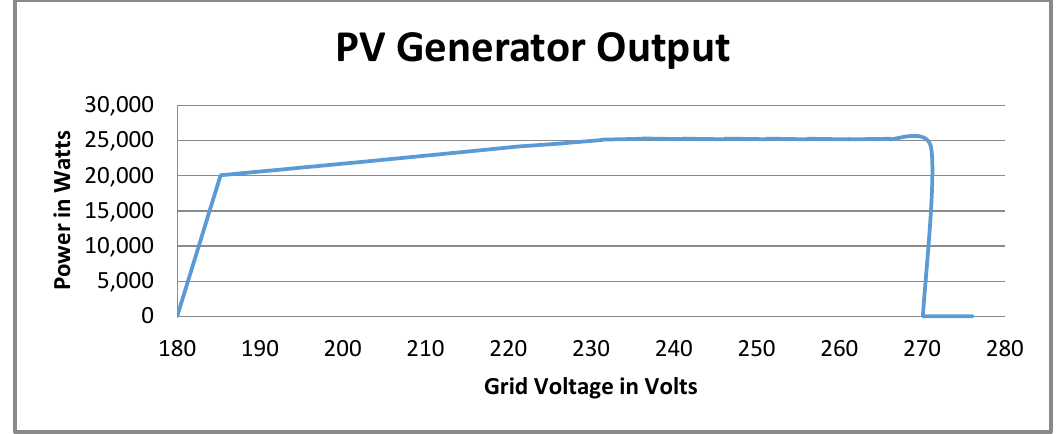
Figure 20. Active power control for the variation in frequency in islanded mode.